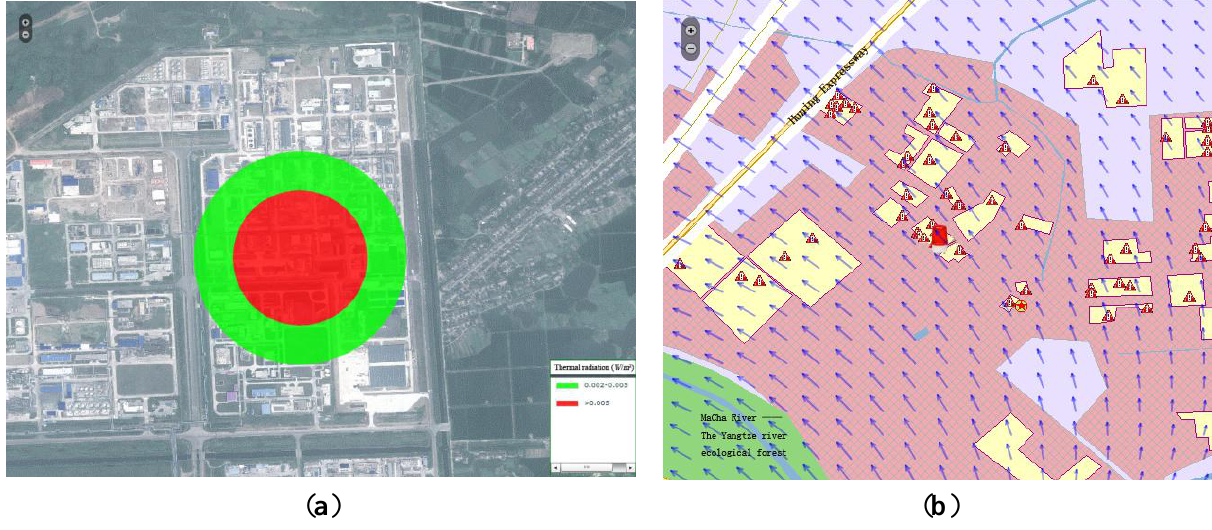
Figure 3. Spatial representation of the scalar and vector data in the context of the geo-reference environment. Image ( a ) shows the thermal radio field in the RS (Remote Sensing) image. Image ( b ) shows the wind field in the vector map.